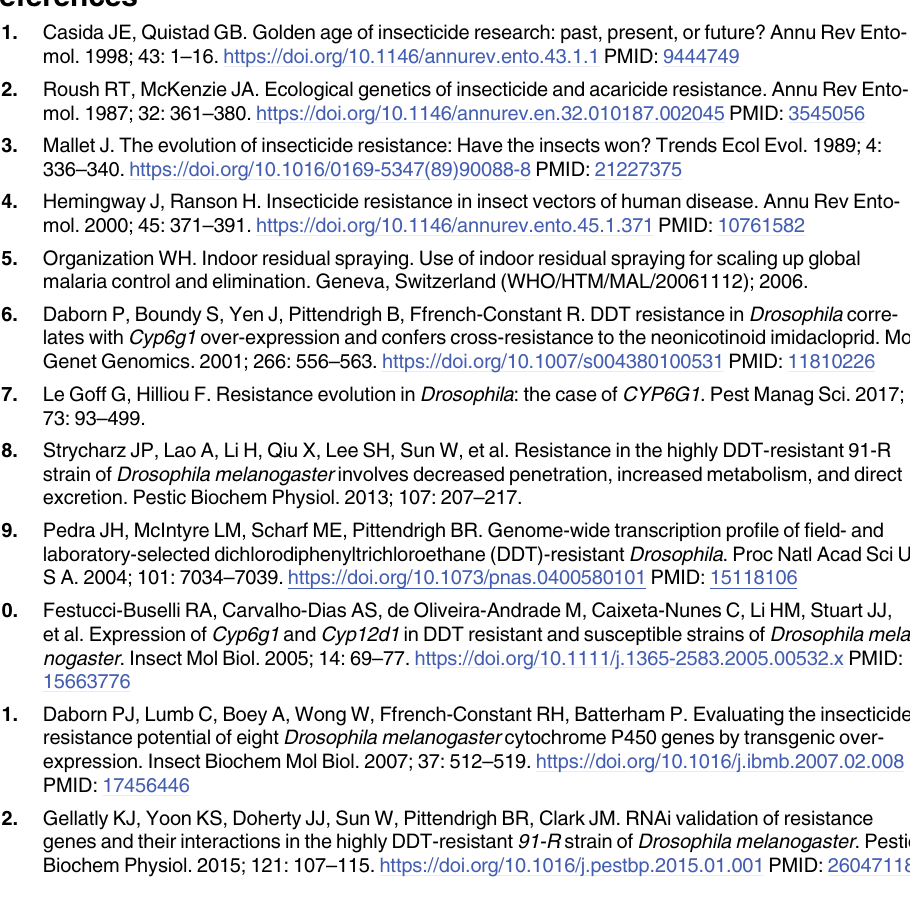
S8 Table. The pathway annotation of target transcripts from known differentially expressed miRNAs. S9 Table. Target genes for novel miRNAs predicted by RNAhybrid in this